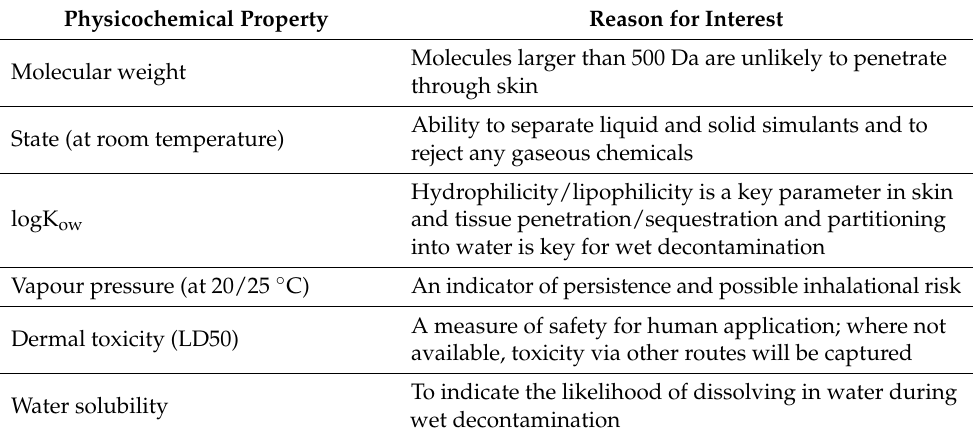
Table 2. Physiochemical properties of interest for liquid and solid simulants, including the reason why that property is relevant to decontamination